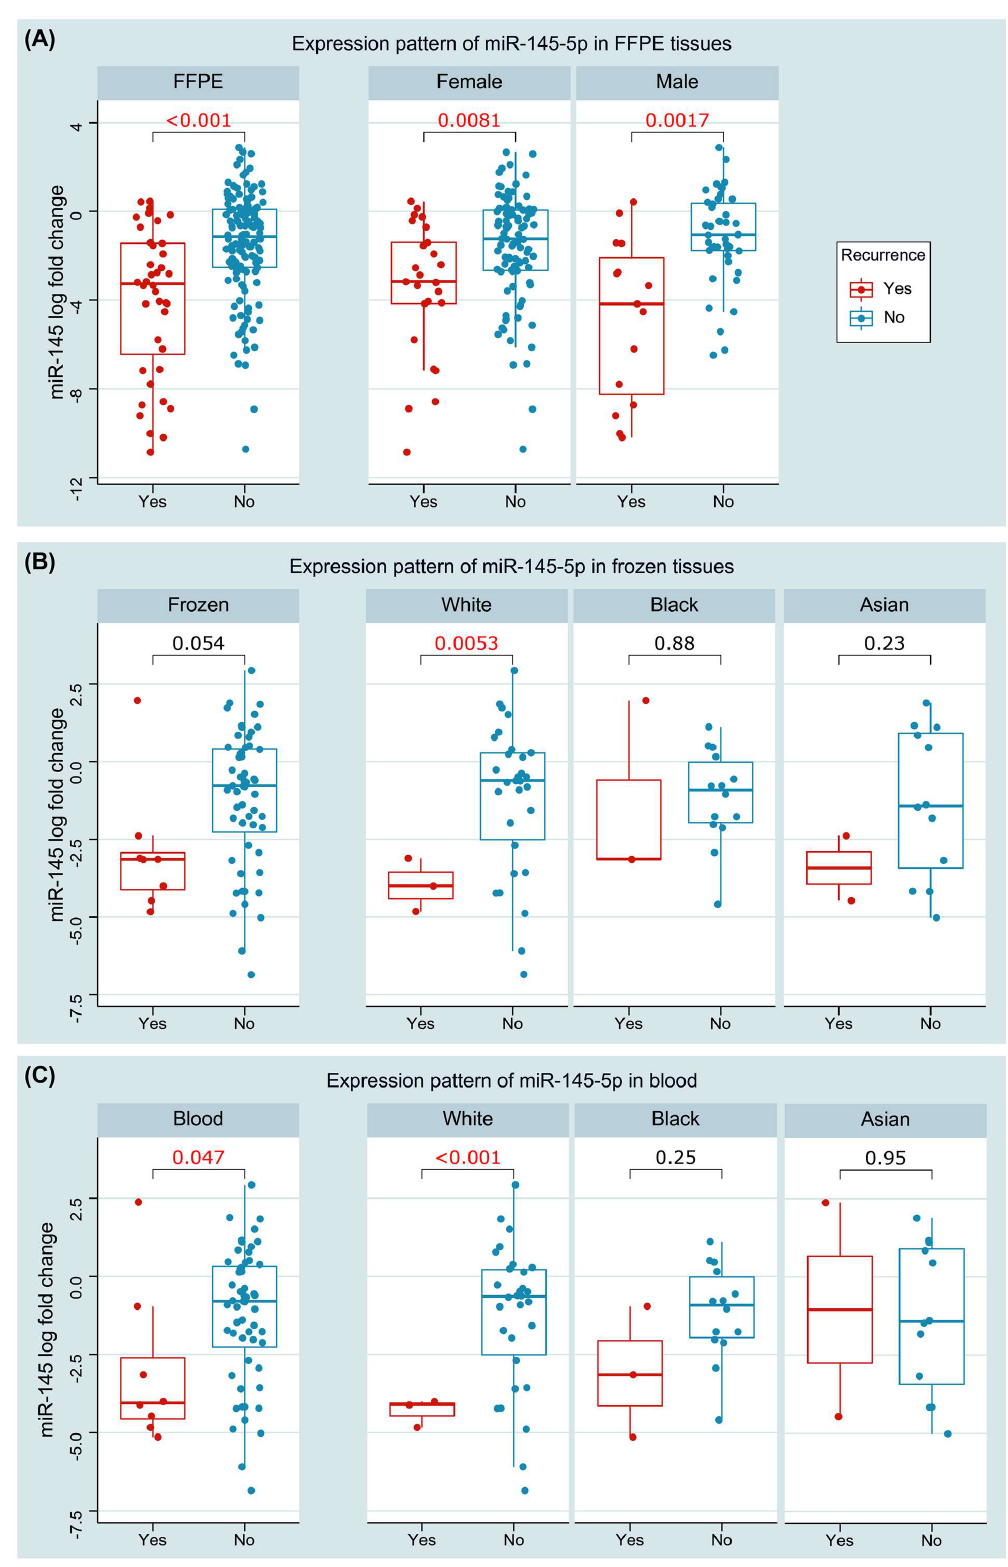
Figure 6. Association of miR145 expression with recurrence. ( A ) Expression in paired FFPE tissues (overall and stratified by sex). ( B ) Expression in paired fresh frozen tissues (overall and stratified by race). ( C ) Expression in blood of cancer and control groups (overall and stratified by race). Wilcoxon matched-pairs signed rank and Mann–Whitney U tests were used. Red values are significant at p <